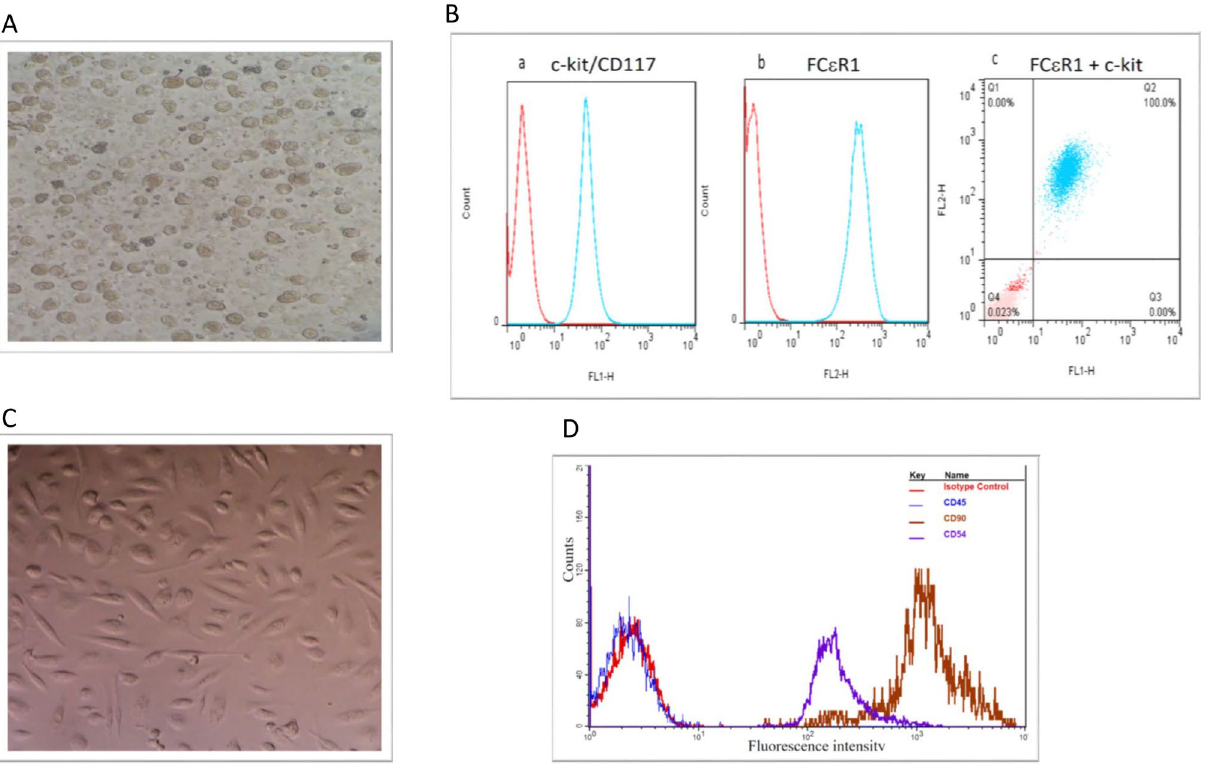
Figure 1. Characterisation of bone marrow-derived mast cells (MCs) and mesenchymal stem cells (MSCs) by morphology and flow cytometry. ( A ) Representative photomicrograph of rat bone marrow cells following culture in complete medium (as described at M&M section) in presence of splenic supernatant of rat pokeweed medium [PWM-SCM, 20% (v/v)] on day 23 (passage 4–5) showing rounded mast cell morphology with intracellular granules. > 92% of cells gave evidence of MC differentiation. Representative flow cytometric analysis of these cells ( B ) demonstrated staining for CD117 (c-kit) (Ba), FC ϵ RI (Bb) and dual staining for CD117 and FC ϵ R (Bc). ( C ) Cultured bone marrow cells as described at M&M section after passage 3–4 had the appearance of a single population of adherent MSCs with a spindle-shaped morphology. ( D ) Flow cytometric analysis of confluent MSCs determined the cell surface expression of CD54-FITC and CD90-FITC and no expression of CD45-PE. IgG1 was used as an isotype control. Demonstrated data is flow cytometric analysis of mesenchymal stem cells in one of independent